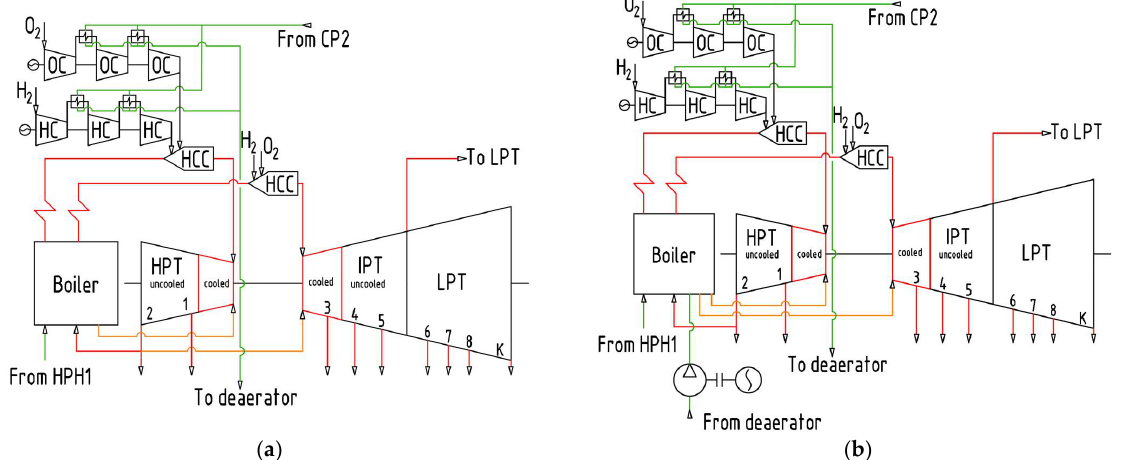
Figure 3. The heat flow diagram of the power unit with HCC, HPT cooled with steam from boiler header, and IPT: ( a ) Cooled with steam from HPT exhaust; ( b ) cooled by steam produced in the boiler special surfaces.